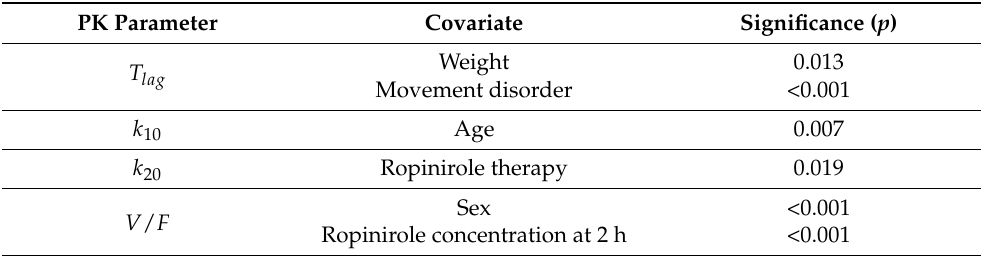
Table 3. Results of the Wald test of significance of the